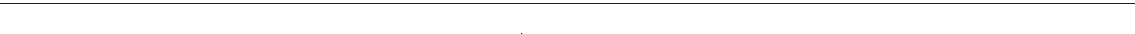
Fig. 5 Tongue and squamous stomach tumour incidence in Krt76 − / − mice. a Schematic of 4NQO tumorigenesis protocol. b Representative macroscopic views of each stage of tongue tumour development. c, d Representative images of hematoxylin & eosin staining (H&E) ( c ) and X-gal staining (blue) ( d ) and respective macroscopic views of the tongue of control ( n = 41 mice) and Krt76 − / − mice ( n = 16 mice). X-gal staining is used to visualize Krt76 expression. e Immunostaining for Krt76 (green) and Loricrin (red) (terminal differentiation marker) in a tongue section bearing two tumours, one of which expresses Krt76. f Tumour incidence in Krt76 + / + ( n = 14, median = 17 weeks), Krt76 + / − ( n = 27, median = 16 weeks) and Krt76 − / − mice ( n = 16 mice, median = 10.5 weeks) (no signi fi cant difference between the wild-type Krt76 + / + and the heterozygous Krt76 + / − controls; **** p < 0.0001 for Krt76 − / − when compared to both controls; one-way ANOVA, Mantel – Cox test and Grehan – Breslow – Wilcoxon test). g Incidence of squamous stomach tumours in control (Krt76 + / + and Krt76 + / − ) ( n = 16) and Krt76 − / − mice ( n = 9) harvested 16 – 28 weeks after the initiation of 4NQO treatment. h Representative images of H&E and X-gal staining (blue) of tumours in the squamous stomach. X-gal staining is used to visualize Krt76 expression. Dotted lines delineate the squamous stomach area. Scale bars: 100 µ